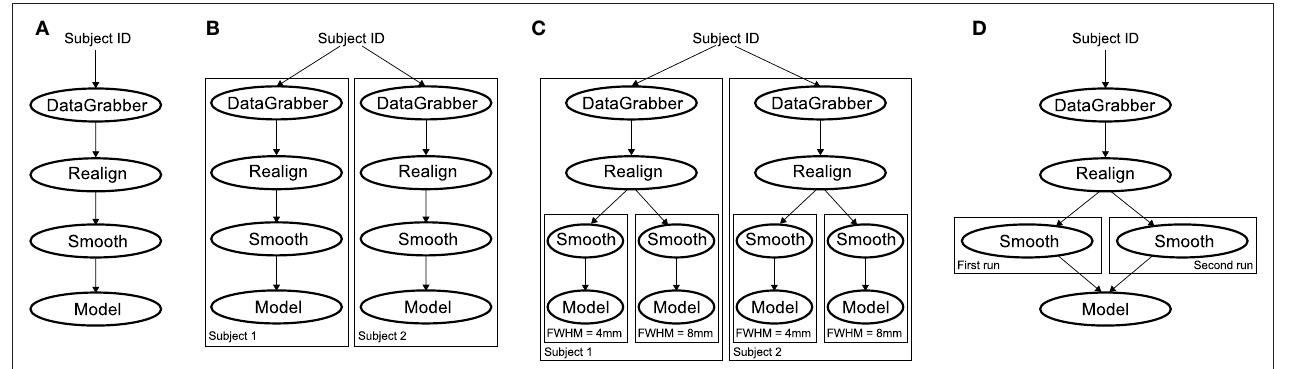
a graph on many levels. For example, setting iterables on Smooth FWHM to a list of 4 and 8 mm will result in graph (C) . In contrast to iterables , MapNode branches within a node of the graph and also merges the results of the branches, effectively performing a MapReduce operation